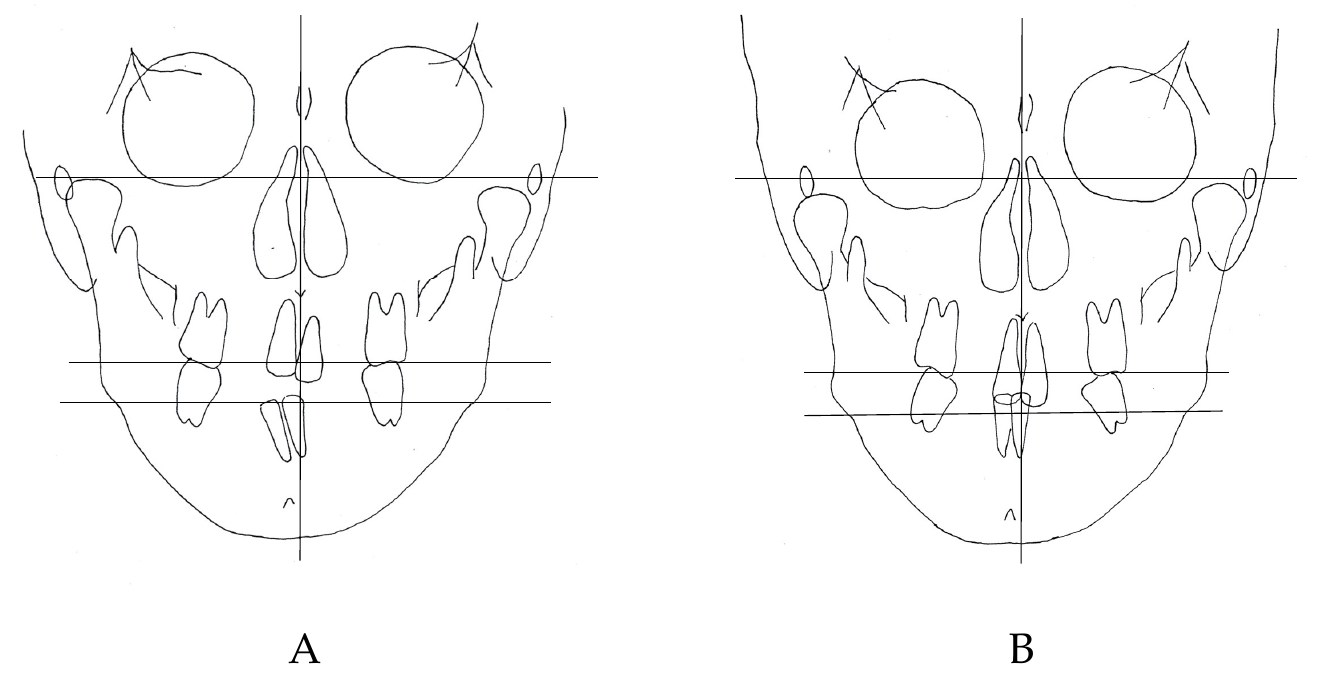
Figure 12. Posterior–anterior cephalometric tracing. ( A ) Pre-treatment (14 y 7 m); ( B ) post-treatment (18 y 1 m).